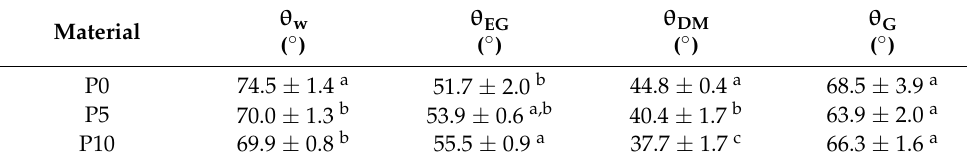
Table 1. Contact angle ( θ ) of poly(lactic acid) (P0) and active films (P5 and P10).